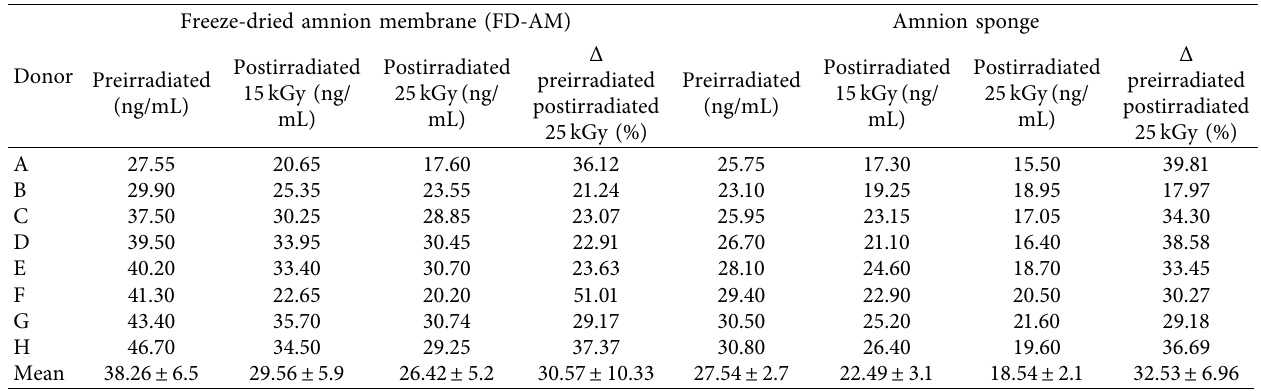
Table 7: Comparison of bFGF levels in the freeze-dried amnion membrane (FD-AM) before and after radiation sterilization. Postirradiated 15kGy Postirradiated 25kGy Preirradiated